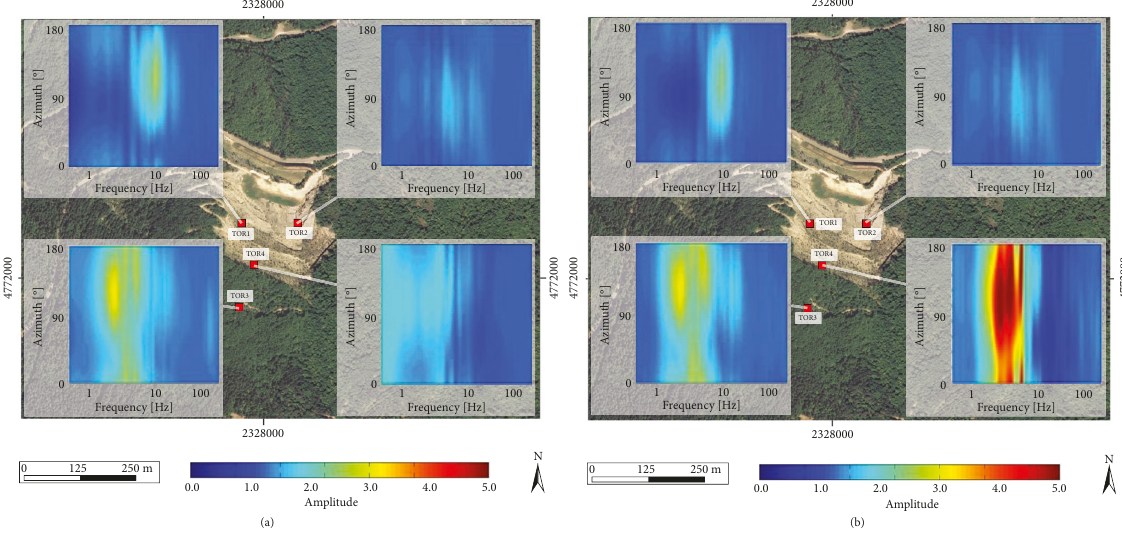
Figure 7: The HVSR directivity in (a) December 2012 and (b) July 2013. Table 1: Correlation test between cumulative rainfall and extensometer data (Cum RAIN – Ei, where i=1, 2 ... 15), and temperature and E12 extensometer data (Temp – E12).